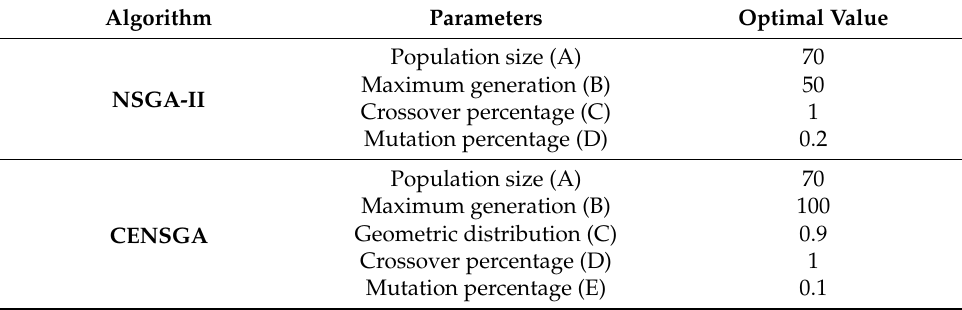
Table 3. Optimal values for the parameters of NSGA-II and